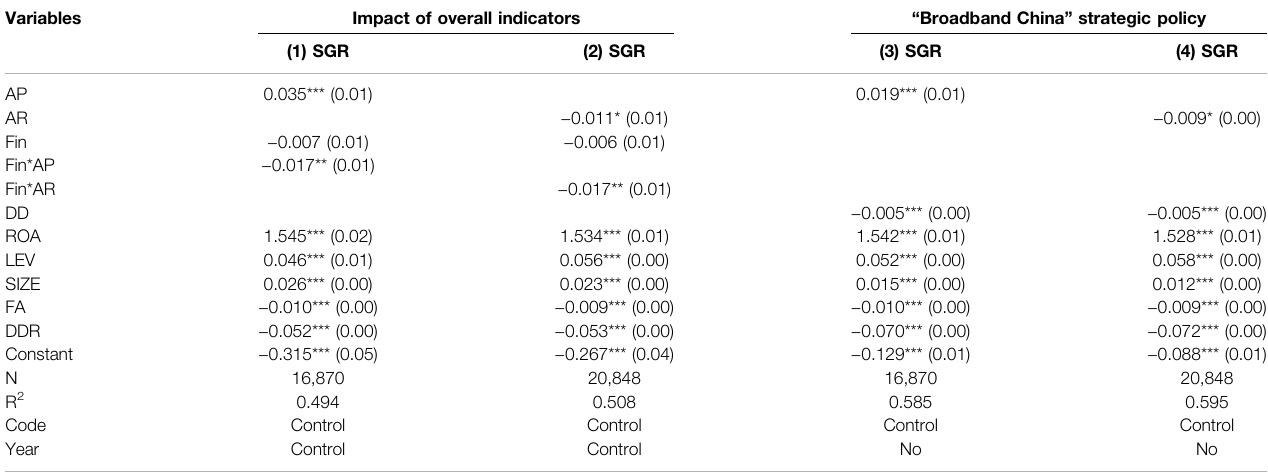
TABLE 12 | Total digital fi nance index and “ Broadband China ” policy impact.